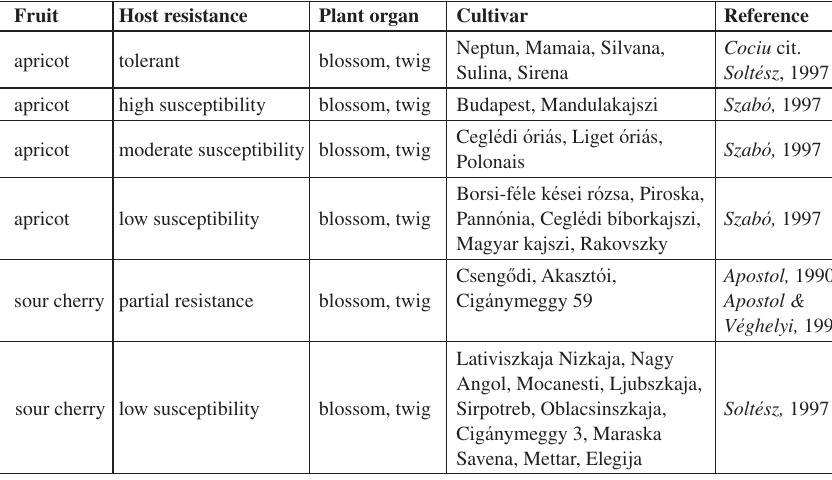
Table 1 Examples of resistant and susceptible fruit cultivars to blossom and twig blight caused by Monilinia